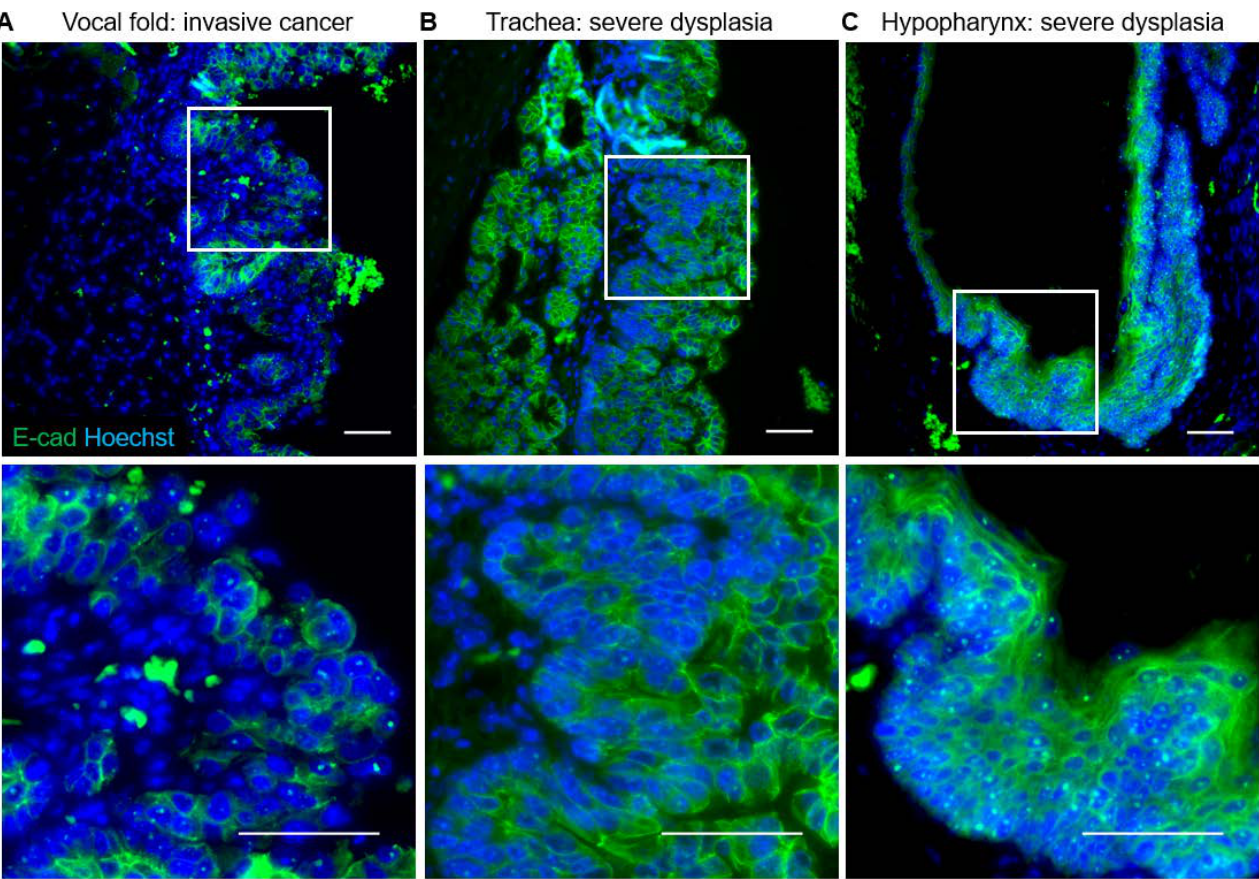
Figure 10. Nuclear E-cadherin in MmuPV1-induced cancers and severe dysplasias. Diseased tissues costained for E-cadherin (green) and Hoechst (blue) IF. Top row: 40× magnification. Bottom row: higher magnification of areas indicated by boxes. Scale bars = 50 um. ( A ) Vocal fold. ( B ) Trachea. ( C ) Hypopharynx.